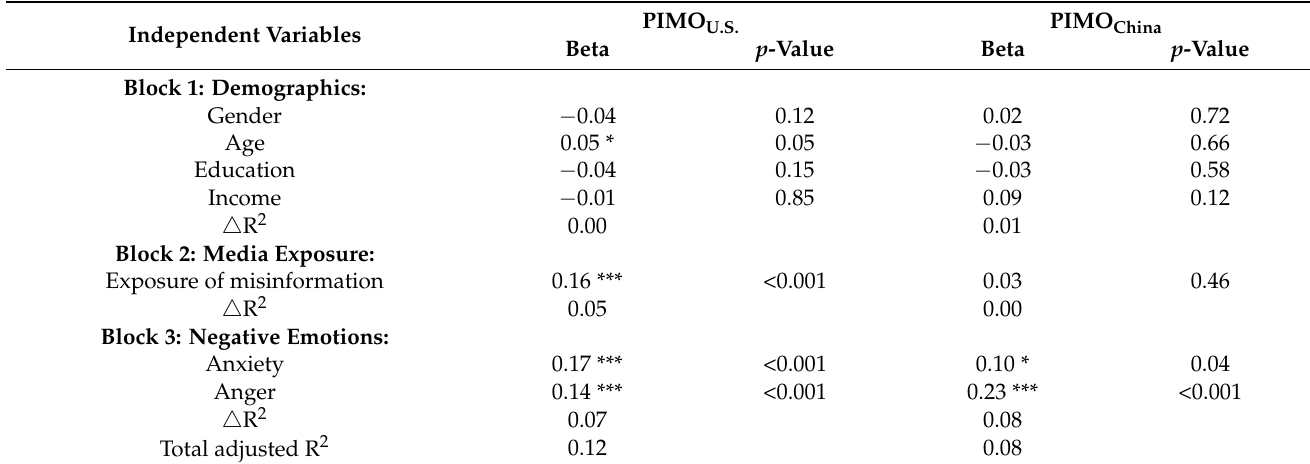
Table 1. Hierarchical Regression Analysis Predicting the Presumed Influence of Misinformation on Others (PIMO) in both U.S. and China.